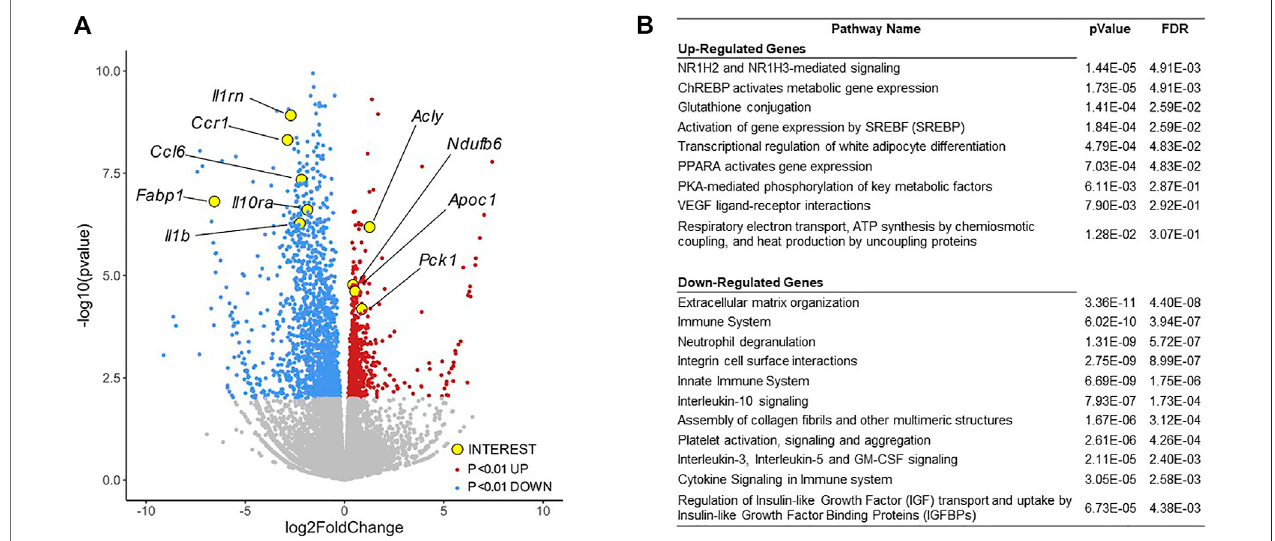
FIGURE 4 | RNA-sequencing Analysis of Gene Expression Changes in the aPU.1KO Mice. (A) Volcano plot showing gene expression changes in adipocytes isolated fromthe gonadal adipose tissue,with keygenesofinteresthighlightedin yellow. (B) Gene ontology analysisofdifferentially expressed genes( p < 0.01) showing highly enriched pathways. The false discovery rate (FDR) is used for multiple hypothesis testing, with a standard cutoff of FDR < 0.05 for signi fi cant pathway